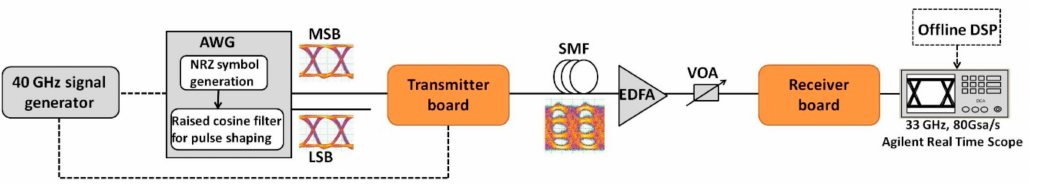
Figure 5. The setup that was used for the full-link